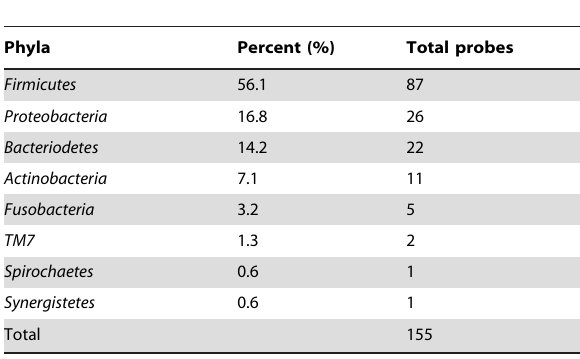
In the analysis of 11 patients there were 155 probes divided among 8 different phyla. This chart represents the percentage of probes per phyla ordered by most common to less common.